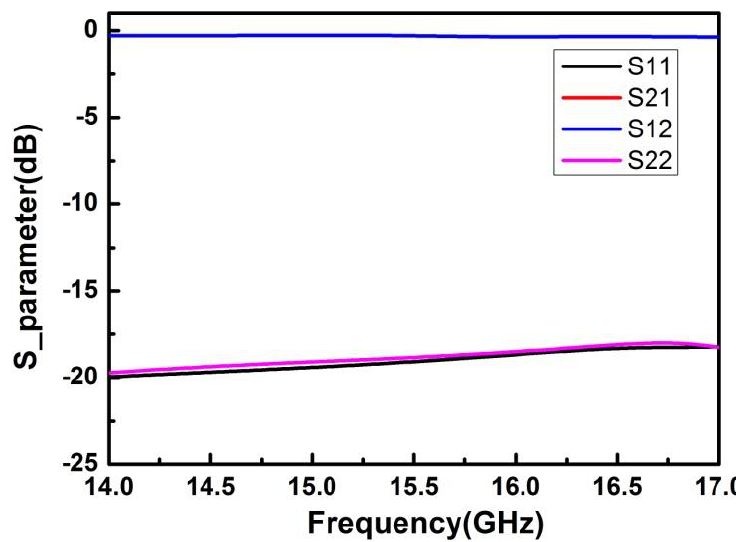
Figure 4. Simulation results of the S-parameters of the SIP.